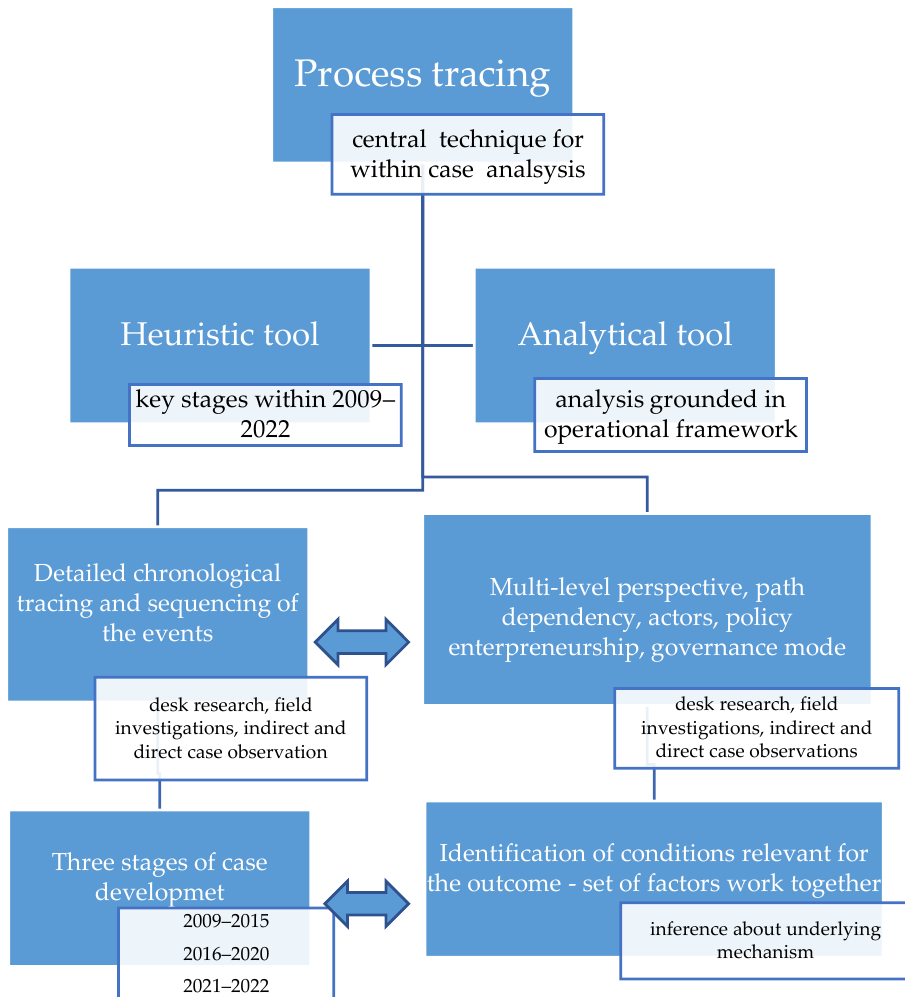
Figure 2. Within-case analysis used in the case study of the municipality of Priboj.